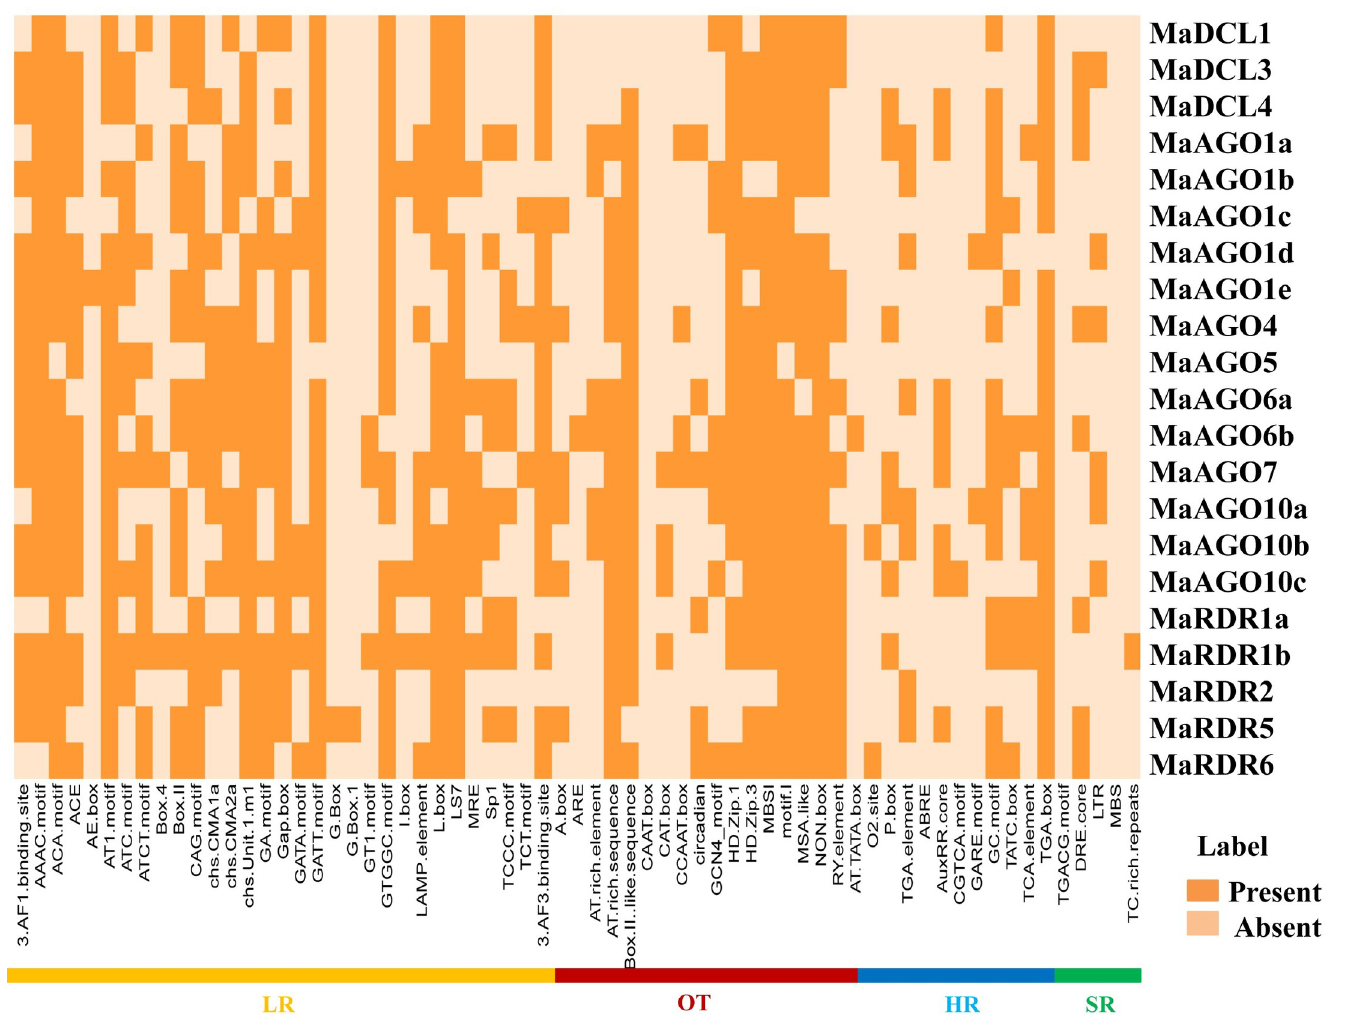
Fig 14. The CAREs in the upstream promoter region of predicted MaDCLs, MaAGOs and MaRDRs genes, respectively. The deep color represents the presence of that element with the corresponding